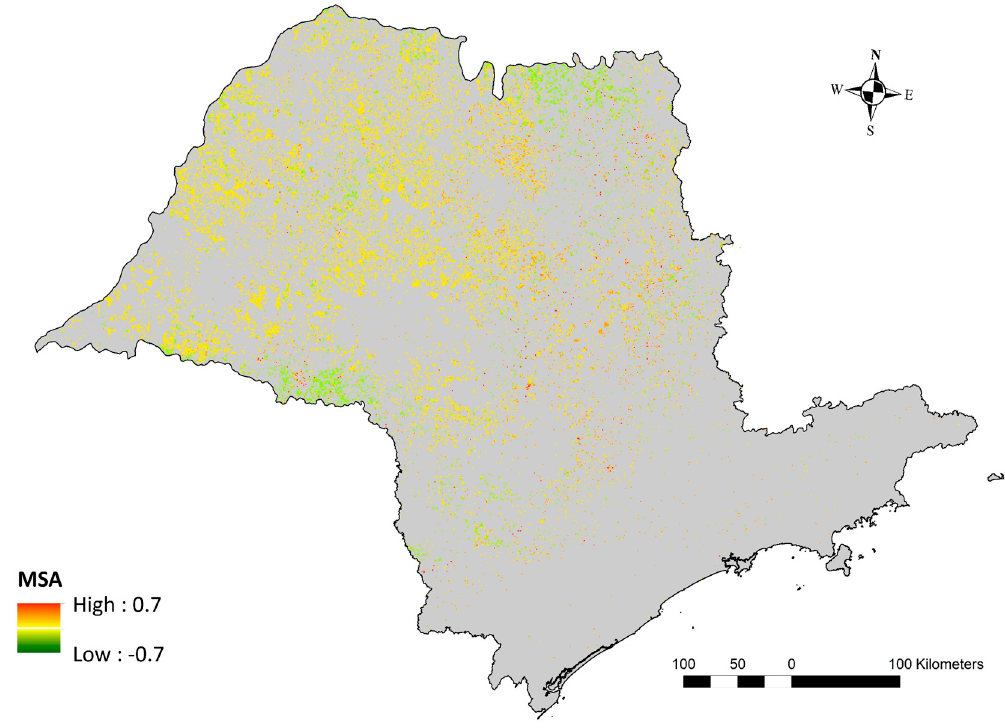
Figure 3. Difference in the mean species abundance between sugarcane and land use/cover prior to conversion for the period of 2005 to 2015. Positive values indicate a loss of mean species abundance.